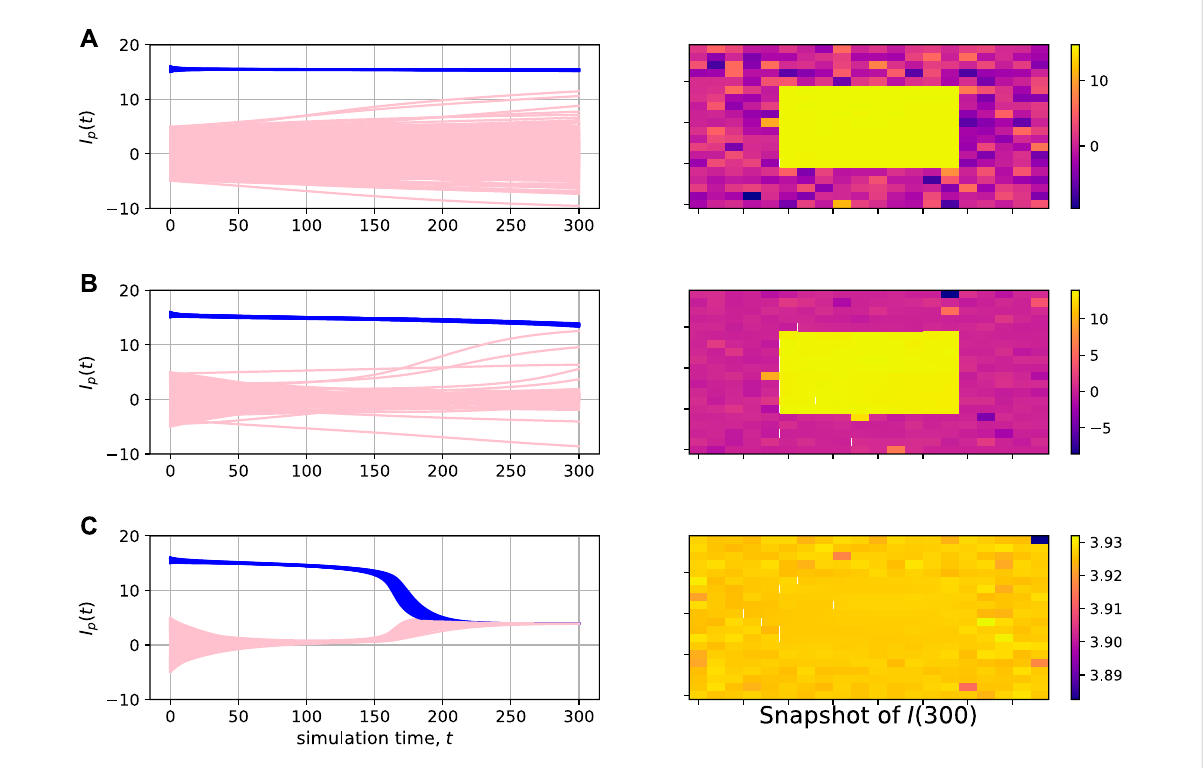
FIGURE 5 Opinion dynamics in the dense city model. Each panel shows the result of a simulation trial. The panels on the left show the changes in the opinions of all individuals over the 300 periods. The opinions of the city inhabitants are plotted in blue, while those of the individuals are plotted in pink. The panels on the right show snapshots of the opinions of individuals mapped in a two-dimensional grid at the 300th period. Here, the parameters were (| N |, α , β , θ , δ ) = (400, 1, 10, 0.7, 0.002) and (| N ′ |, κ , κ 1 , κ 2 , δ ′ ) = (100, 5, 15, 16, 0.04), with (A) γ = 0.01, (B) γ = 0.2, and (C) γ = 0.5.